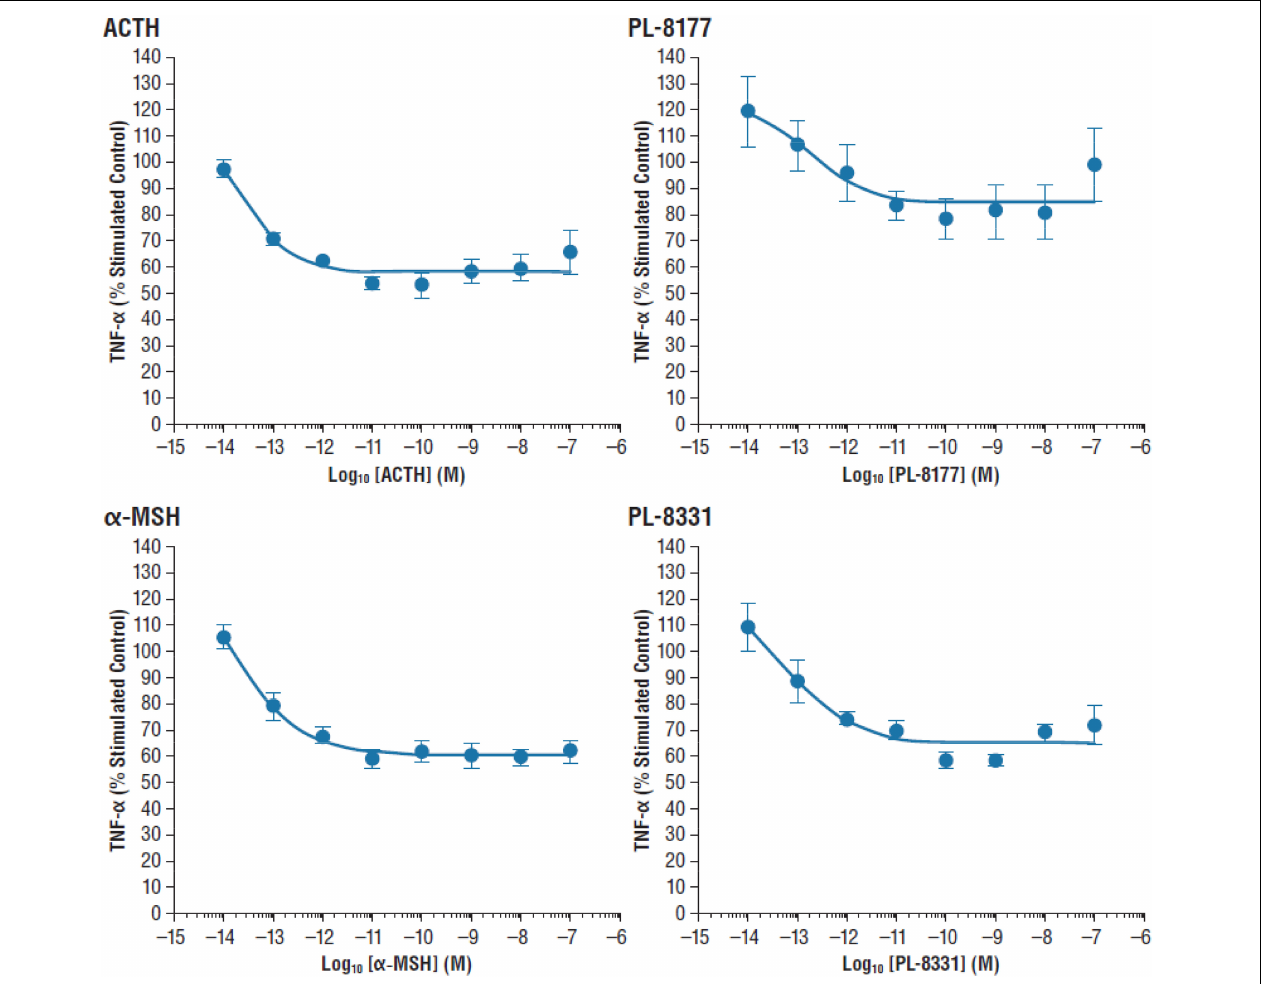
FIGURE 1 | Inhibition of lipopolysaccharide-induced TNF- α inhibition in human whole blood. α -MSH, alpha-melanocortin stimulating hormone; ACTH, adrenocorticotropic hormone; TNF- α , tumor necrosis factor